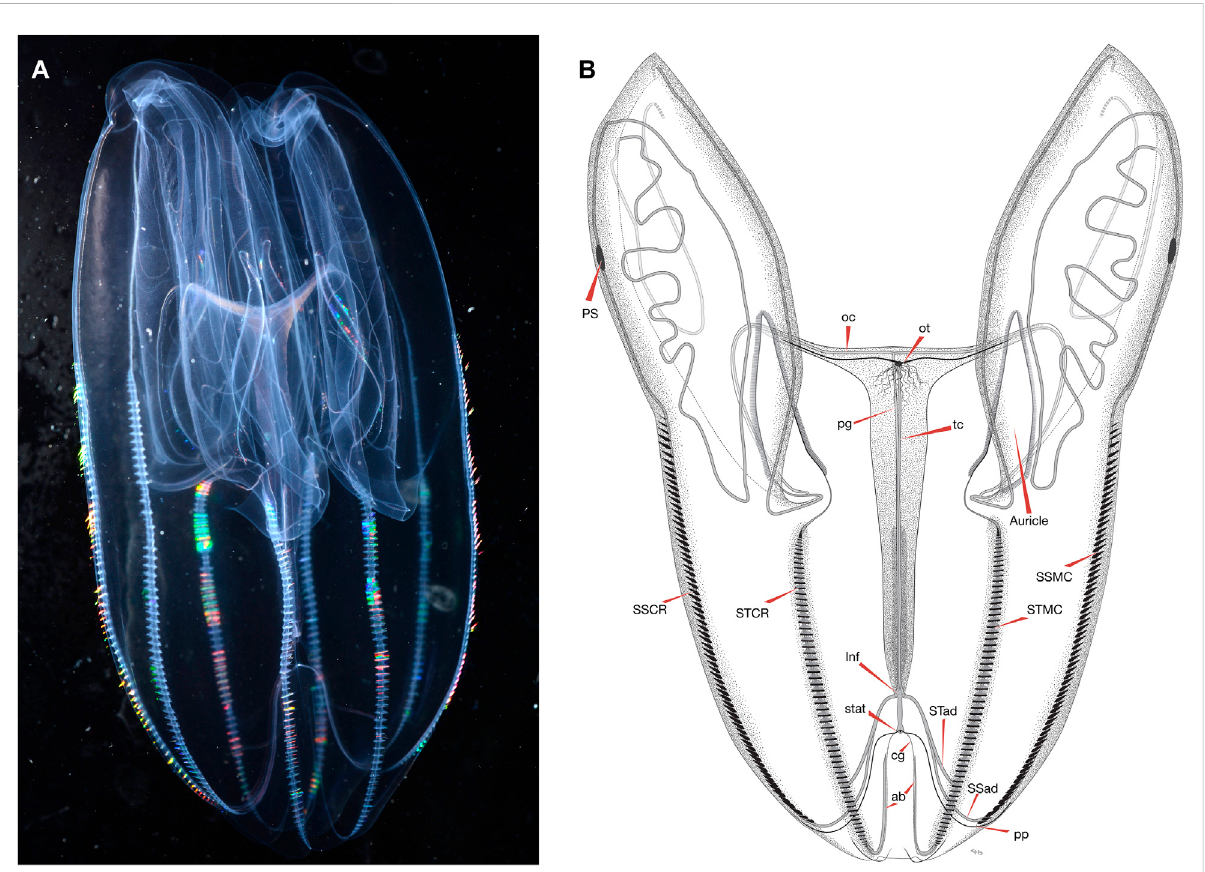
FIGURE 2 (A) An imageof B.microptera from easternPaci fi cOcean with a “ relaxed ” body position and (B) anillustration of B.microptera from theeastern Paci fi c Ocean with morphological landmarks indicated by arrows for: auricle, oral tentacle (ot), pigment spot (PS), oral canal (oc), paragastric canal (pg), tentacular canal (tc), sub-stomodaeal comb row (SSCR), sub-tentacular comb row (STCR), infundibulum (Inf), ciliary groove (cg), aboral projection (ab), sub-stomodaeal meridional canal (SSMC), sub-tentacular meridional canal (STMC), sub-tentacular adradial canal (STad), sub- stomodaeal adradial canal (SSad), and the pole plate (pp). Image and illustration are representative of full-grown specimens, body proportions change as the species